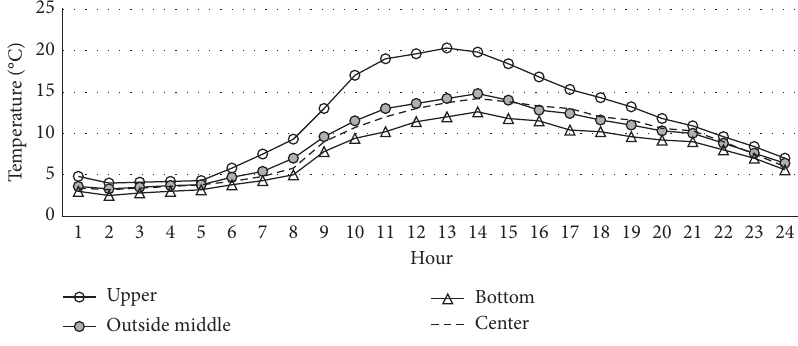
Figure 8: The day temperature curve at each position of the specimens.